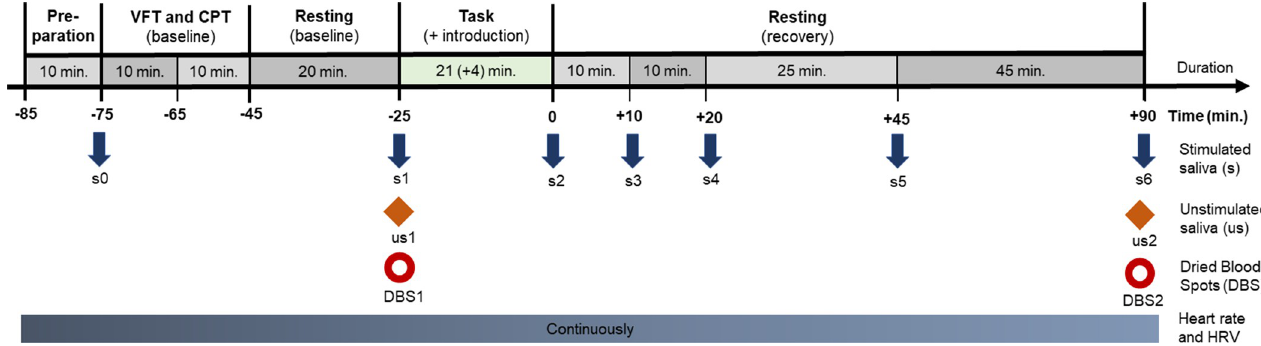
Fig 3. Timeline of the experiment. The entire session will last about 3 hours. A further Dried Blood Spot Sample (DBS 3 ) will be collected 24 hours after DBS 1 (not shown). Note . CPT: continuous performance task; DBS i : Dried Blood Spot # i; HRV: heart rate variability; s i : stimulated saliva sample # i , which will be collected by means of Salivettes; us i : unstimulated saliva sample # i ; VFT: verbal-fluency task.